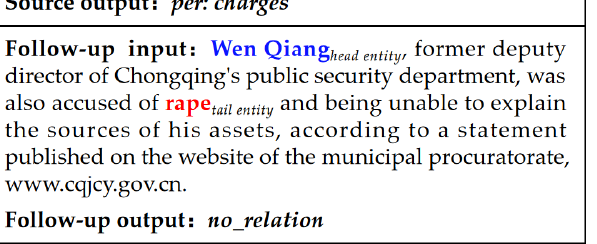
Figure 1. A motivating example. The head entity is marked in blue, and the tail entity is marked in